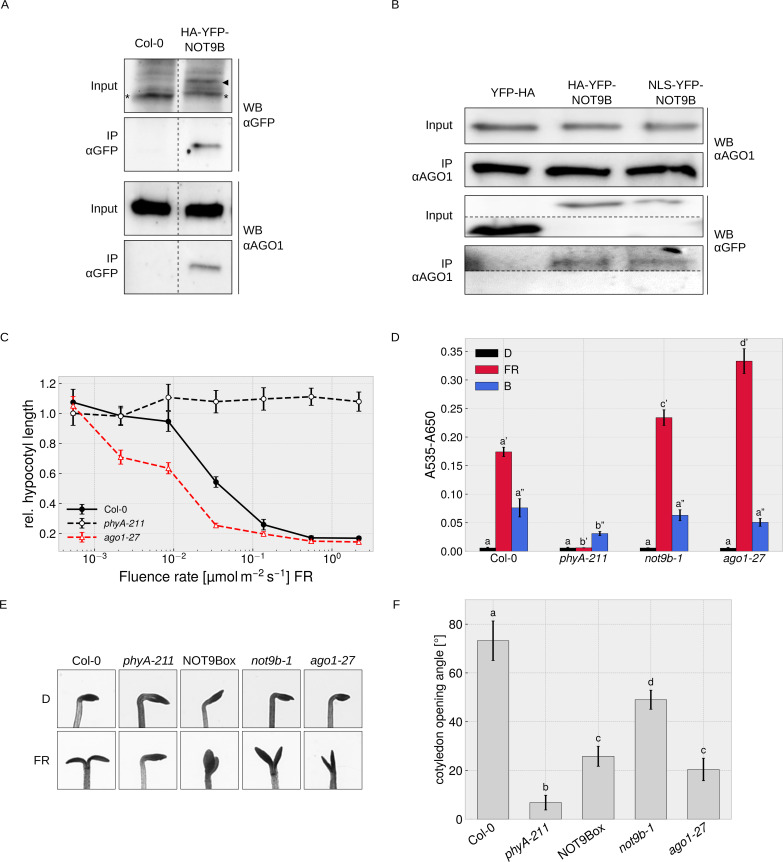
Physical and phenotypical link between NOT9B and AGO1.(A) CoIP from transgenic Arabidopsis lines. Total soluble protein was extracted from 4-day-old dark-grown wildtype (Col-0) and p35S:HA-YFP-NOT9B expressing seedlings (NOT9Box) and used for CoIP with αGFP magnetic beads. Input and eluate fractions were analysed by SDS-PAGE and immunoblotting with αGFP and αAGO1. *, unspecific band; ►, HA-YFP-NOT9B. (B) CoIP from Arabidopsis lines expressing constitutively nuclear localised NOT9B. Total soluble protein was extracted from 4-day-old dark-grown Arabidopsis seedlings expressing p35S:YFP-HA (YFP-HA), p35S:HA-YFP-NOT9B (NOT9Box), or p35S:NLS-YFP-NOT9B (NLS-YFP-NOT9B) and used for CoIP with αAGO1 bound to protein A-coated magnetic beads. Input and eluate fractions were analysed as in (A) using αAGO1 and αGFP antibodies. (C) Fluence rate response curve for inhibition of hypocotyl growth. Seedlings of the indicated genotypes were grown for 4 days in FR light. Mean hypocotyl length (± SE) of 20 seedlings relative to dark-grown seedlings is shown. Absolute hypocotyl length is shown in Figure 7—figure supplement 3. (D) Quantification of anthocyanin content. Seedlings of indicated genotypes were grown on ½ MS supplemented with 1.5% sucrose for 4 days in the dark (D), FR, or B light. Anthocyanin was extracted from 25 seedlings per genotype/condition and A535-A650 was measured. Bars represent biological triplicates (± SD). (D and F) Letters indicate levels of significance as determined by one-way ANOVA followed by post-hoc Tukeys HSD test; p<0.05. (E and F) Cotyledon opening in FR light. Seedlings of indicated genotypes were grown for 4 days in D followed by 24 hr in weak FR light (716 nm, 0.05 μmol m−2 s−1) or D. (F) Cotyledon opening of FR-treated seedlings was quantified by measuring the angle between the cotyledons of 20 seedlings per genotype. Bars show mean cotyledon opening of three biological replicates (± SD).